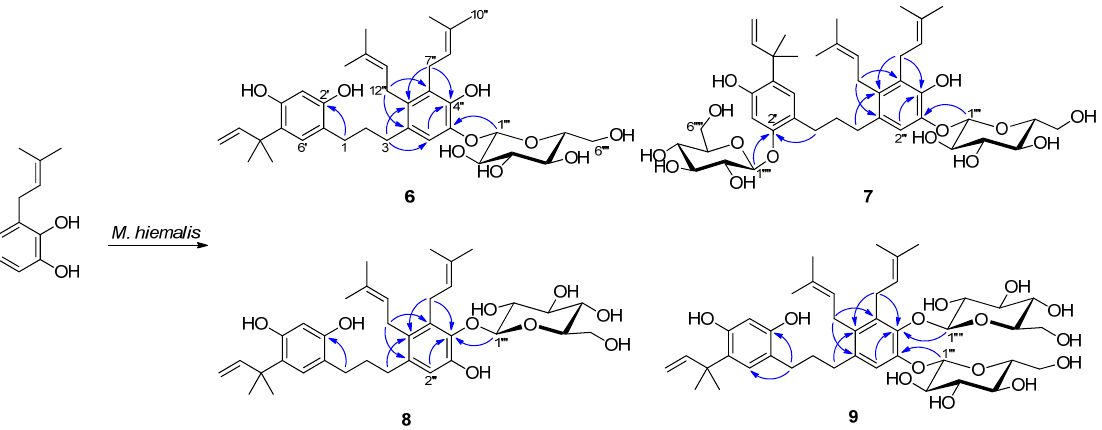
Figure 3. Metabolites of kazinol C ( 1 ) transformed by M. hiemalis . Selected HMBC correlations ( 1 H → 13 C) are indicated by arrows.